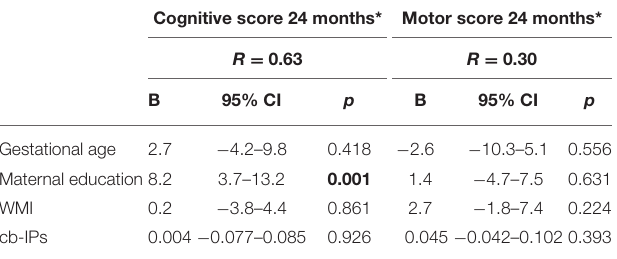
TABLE 3 | Multivariable linear regression analysis between cb-IPs and neurological outcome at 24 months CA.